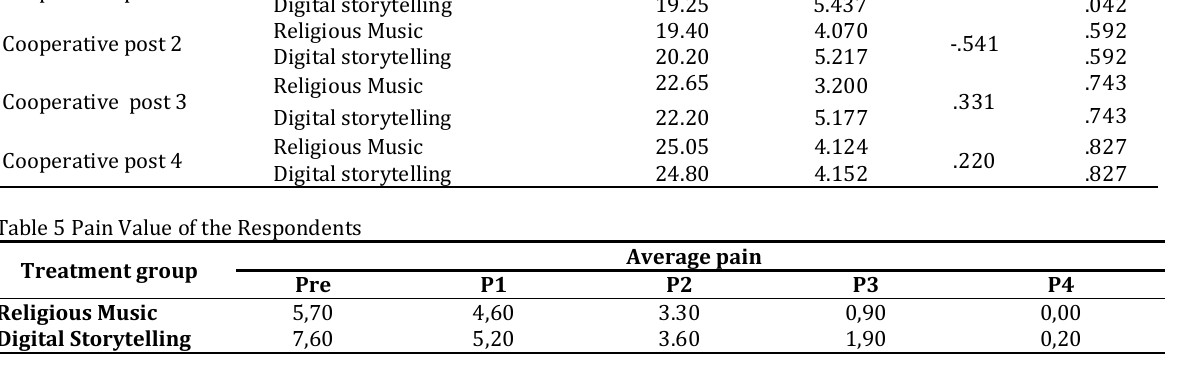
Table 6 Distribution of Respondents Based on Pulse Before and After Being Given Religious Music and Digital Storytelling Treatment